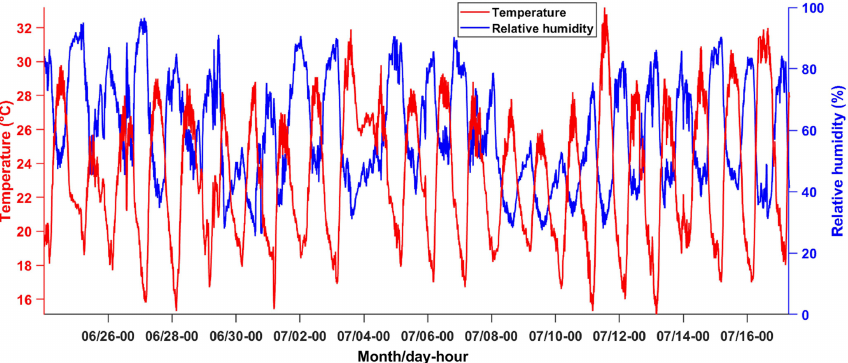
Figure 4. Temporal evolutions (UTC), from 4 June to 17 July 2014, of thermodynamic temperature and relative humidity at 2m above the ground